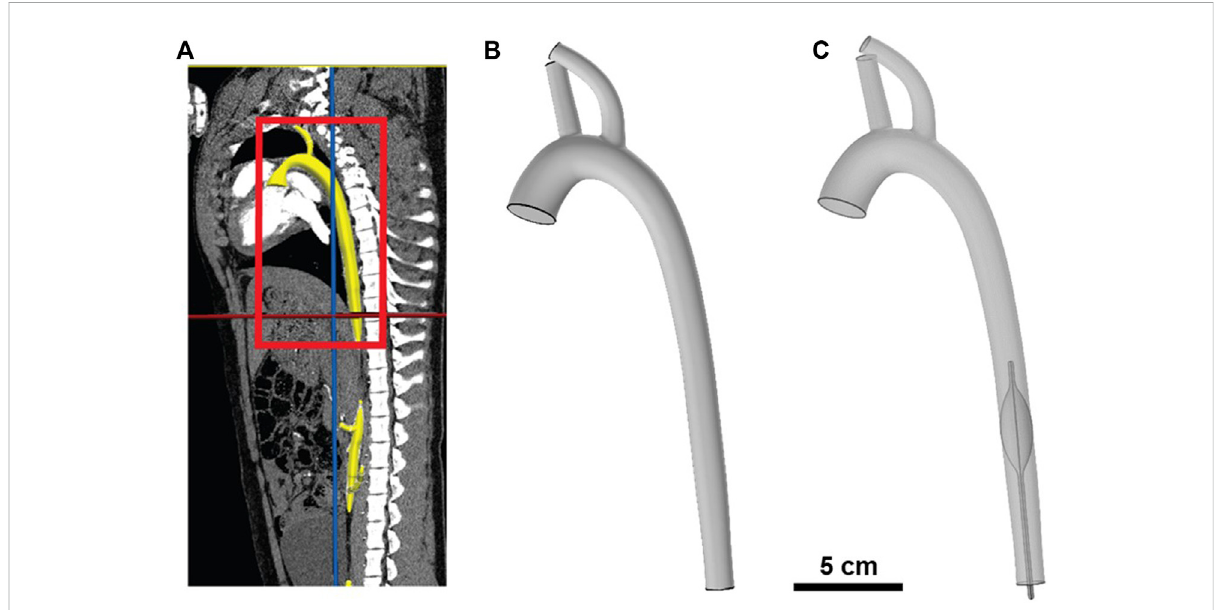
FIGURE 1 Illustration of porcine aorta computational model. (A) Segmentation of porcine aorta from computed tomography (CT) scan; aorta is highlighted in yellow and the region of interest is boxed in red. (B) Geometric 3D model of the porcine aorta. (C) Geometric 3D model of REBOA placement in Zone I (i.e., proximal to